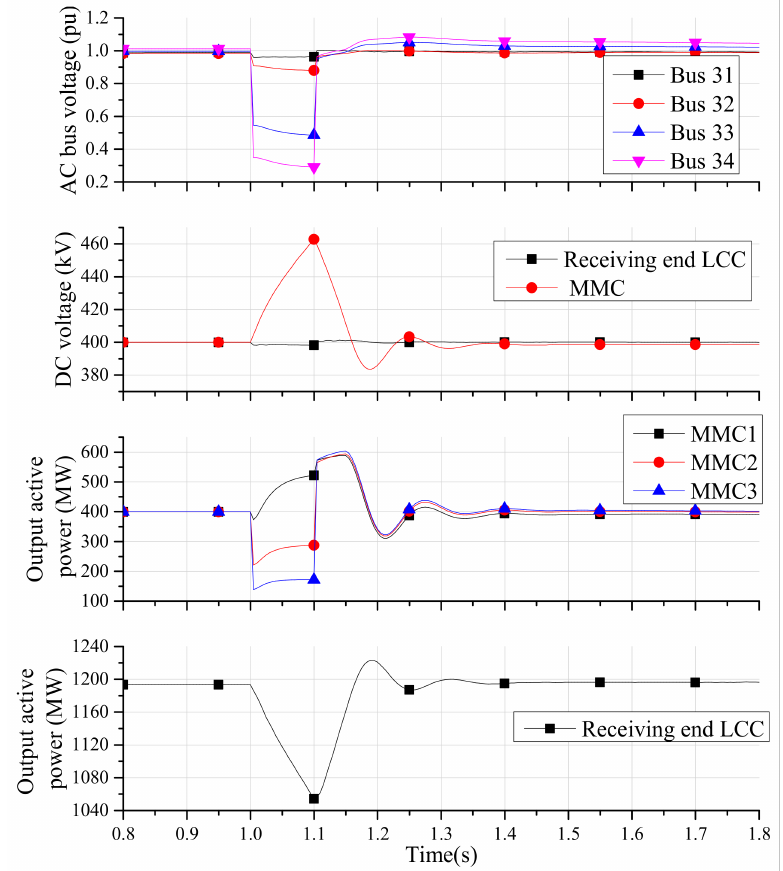
Figure 10. Dynamic response of the HVDC system after an AC short circuit fault